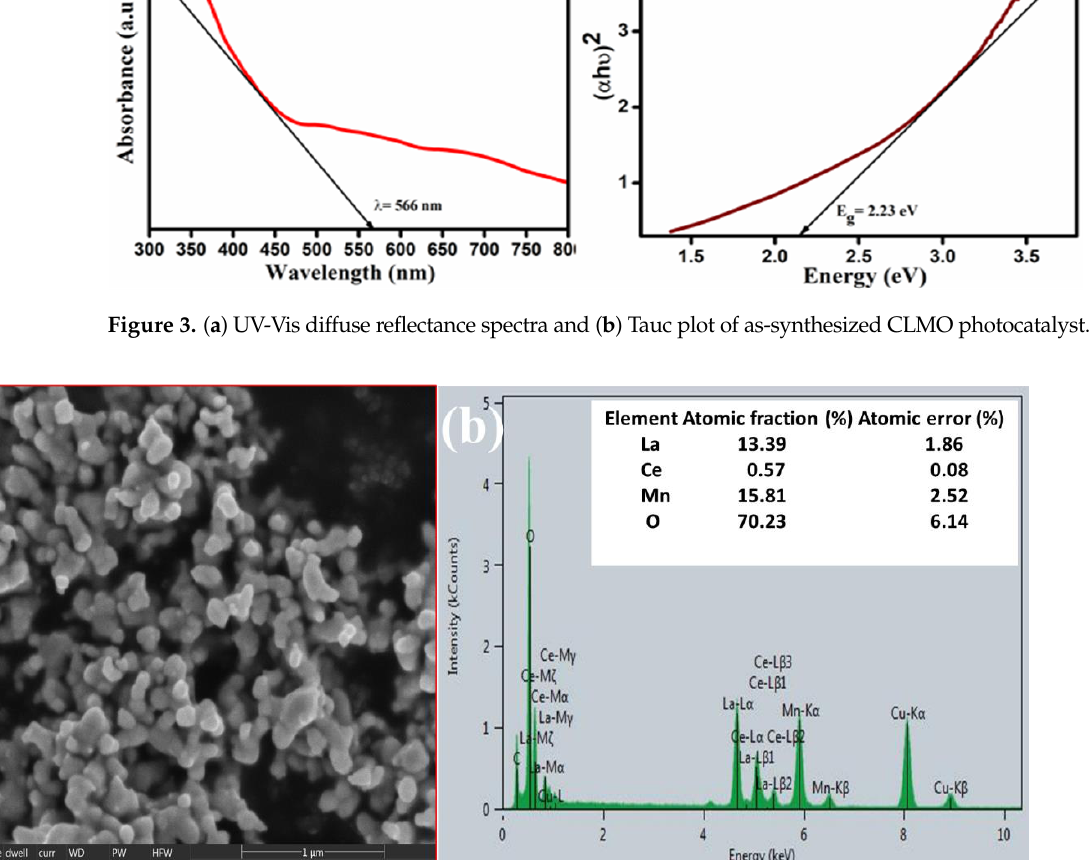
Figure 4. ( a ) FE-SEM image and ( b ) EDX analysis of as-prepared Ce 0.1 La 0.9 MnO 3 (CLMO) nanostructures. The spectrum shows a peak in 8 KeV, which is attributed to ‘Copper’ appearing from the supporting microscopic grid.